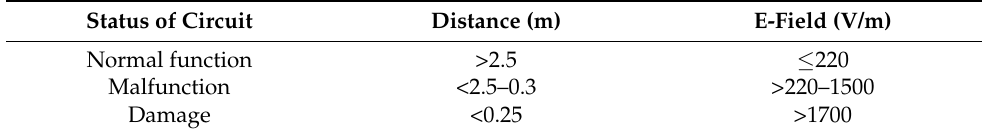
Table 4. Summarized results of IC testing using a low-tech DEW